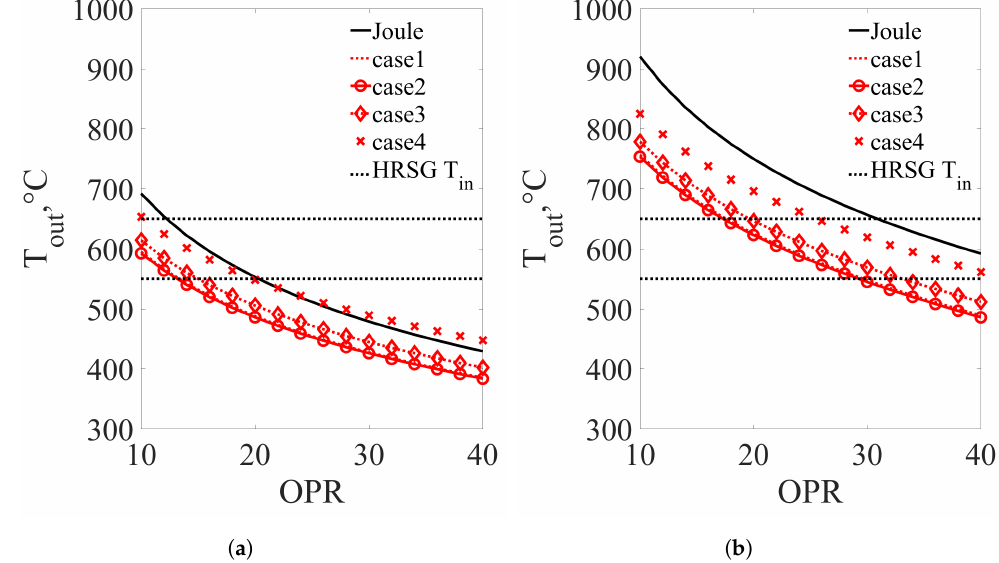
Figure 12. Turbine outlet temperature as a function of the cycle pressure ratio for the four versions of the Humphrey cycle presented in Table 3 and two TIT values. ( a ) Turbine outlet temperature for TIT 1300 ◦ C; ( b ) Turbine outlet temperature for TIT 1700 ◦